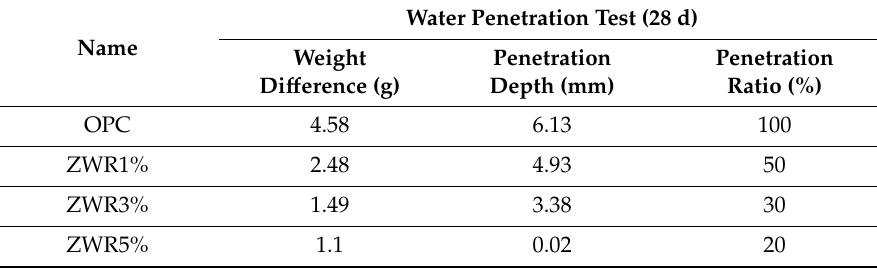
Table 13. Data of accelerated carbonation test (28 days).